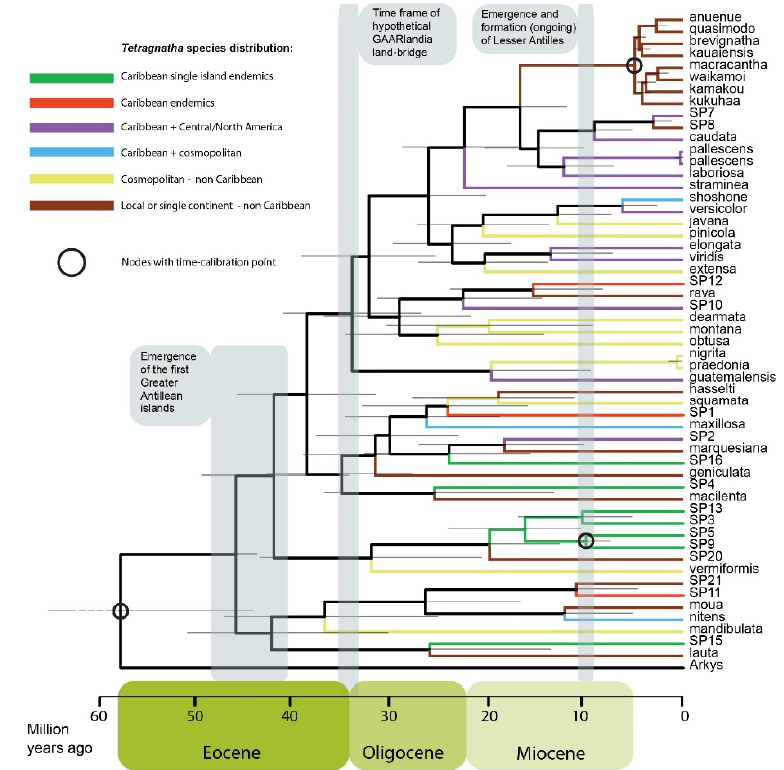
Figure 4. A time-calibrated phylogeny of Tetragnatha . This chronogram from BEAST is consistent with an early Caribbean colonization by Tetragnatha , with multiple overwater dispersal events over the GAARlandia, or with ancient vicariance scenarios. We constrained the topology based on the results from the all-terminal COI phylogeny, therefore, node supports are not shown. Nodal bars represent 95% HPD intervals.